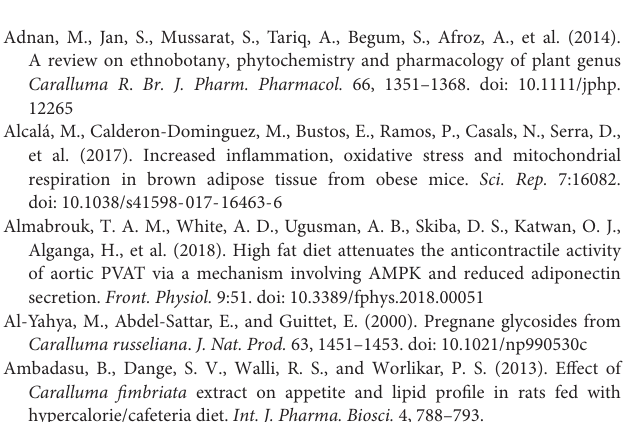
FIGURE S1 | 1 H-NMR spectrum of russelioside B. FIGURE S2 | 13 C-NMR spectrum of russelioside